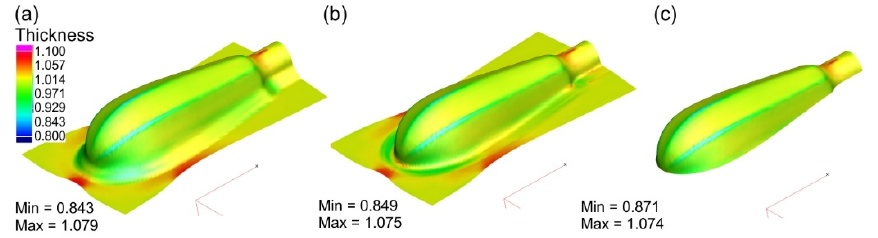
Figure 9. Thickness distribution in drawn part wall after: ( a ) initial forming; ( b ) supplementary forming; ( c ) final forming in dry conditions.